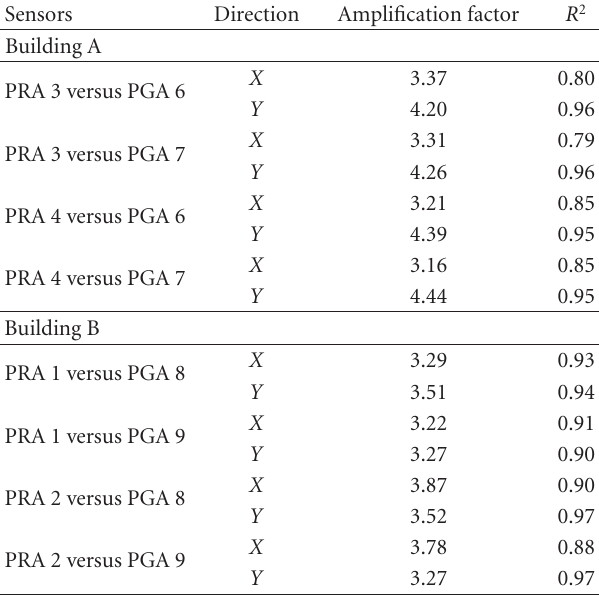
Table 3: Amplification factors between PRA at the roof and PGA at the building